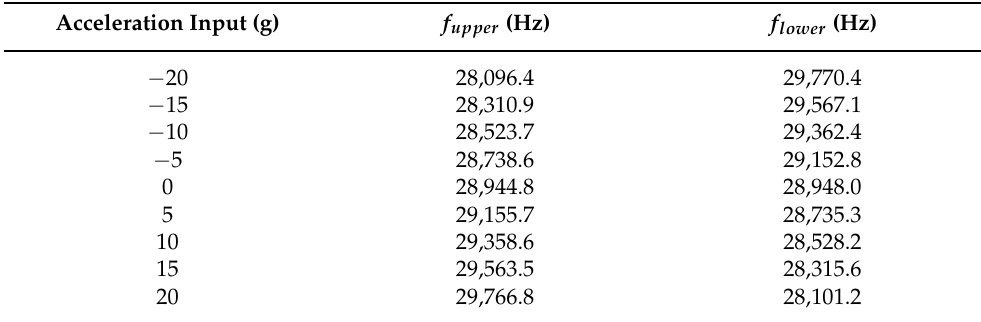
Table 3. Working frequencies of the DETFs of the resonant accelerometer under different accelera- tion input.